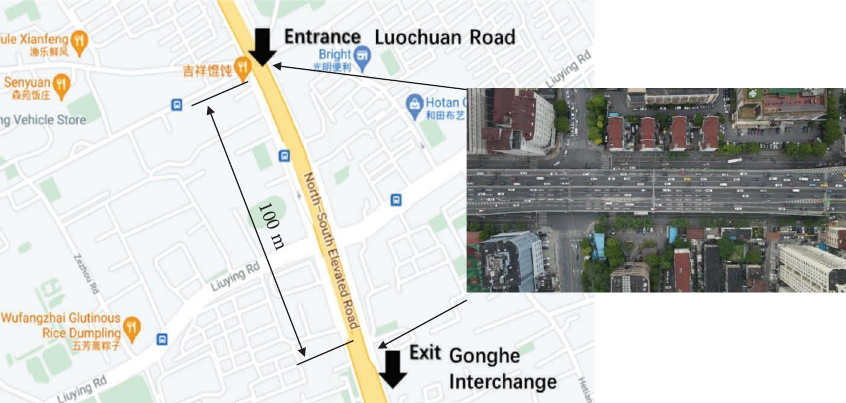
Figure 2: Te weaving section of Luochuan Road-Gonghexin Road